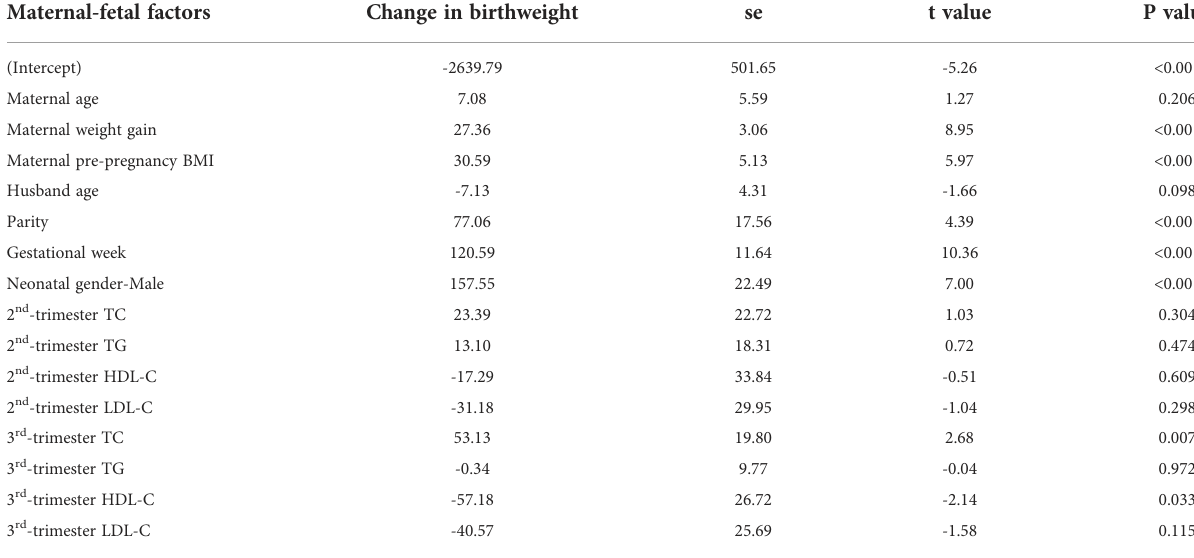
TABLE 2 Relationship between change in birthweight and maternal-fetal factors.